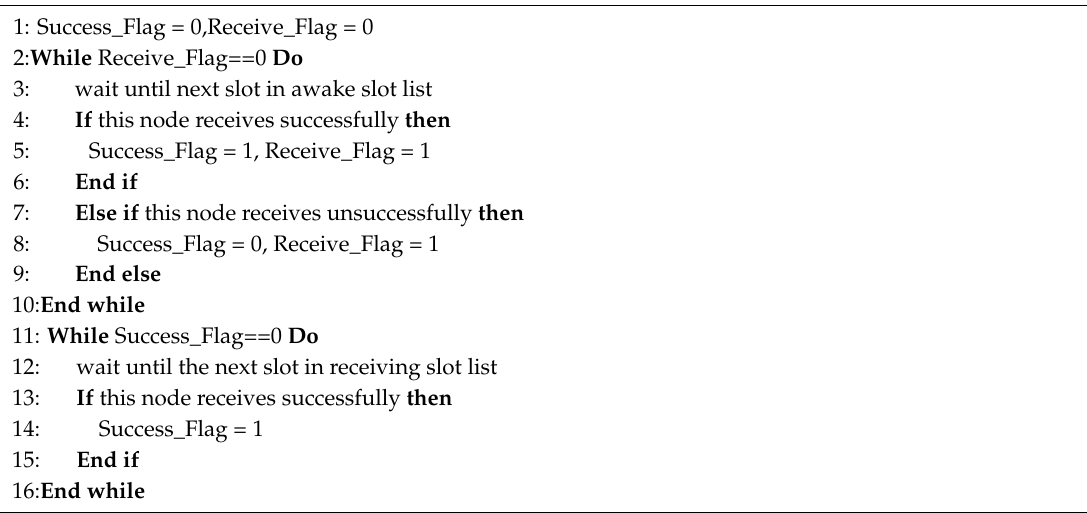
Algorithm 12 Receive data packet under AAPS scheme